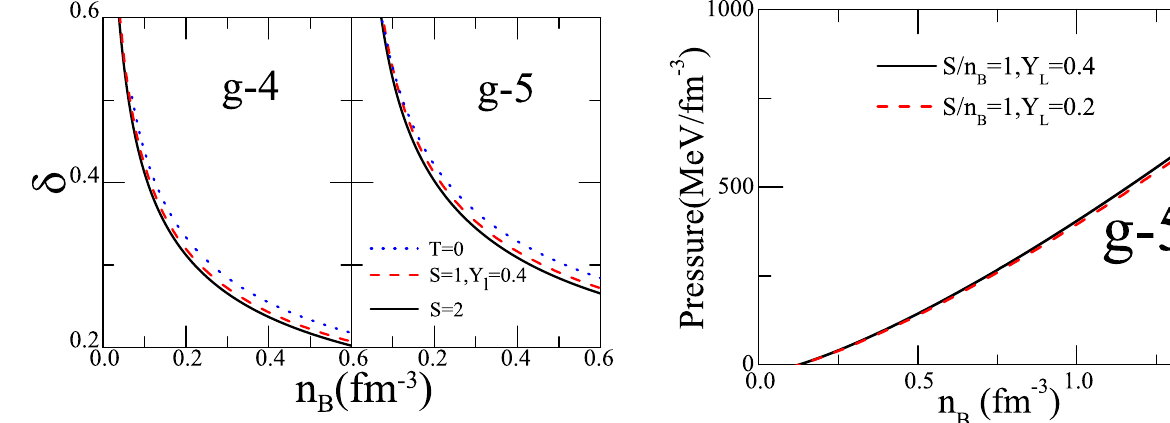
Fig. 9 Pressures as functions of baryon density with different lepton fraction when S / n B = 1 for